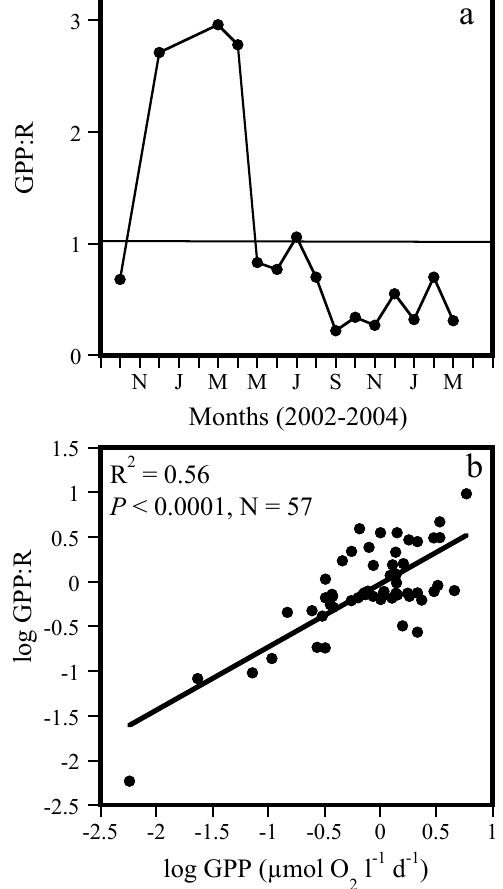
Fig. 8. Trophic balance and planktonic metabolism. (a) , GPP: R and (b) relationship between GPP and GPP: R . Data in (a) are calculated from depth-averaged values. The parameters for the regression line in (b) are y = − 0.051 + 0.677 x for log transformed data using the reduced major axis (r.m.a.) regression